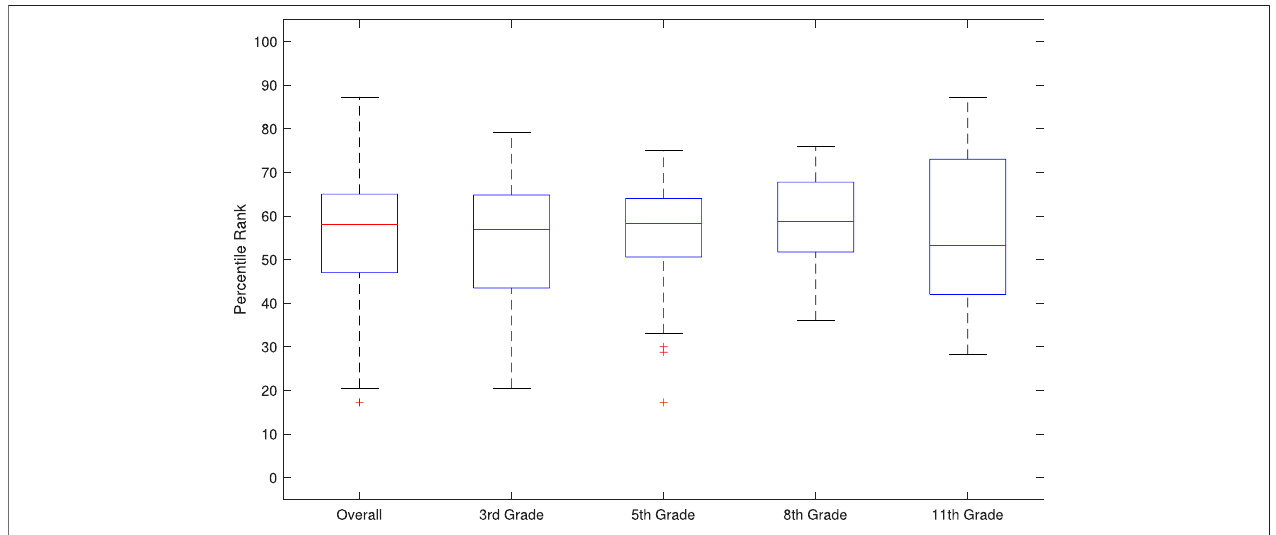
FIGURE 5 | Box plot of the reading achievement scores in terms of percentile ranks, averaged for each classroom ( n (cid:1) 180), shown by grade.